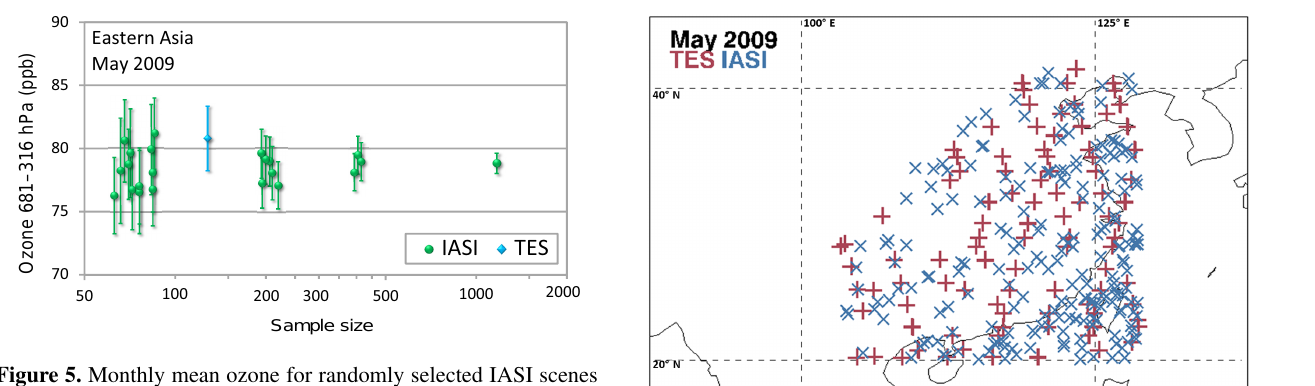
Figure 5. Monthly mean ozone for randomly selected IASI scenes within the eastern Asia ROI for May 2009. IASI-TOE data have been offset-corrected. A sample of 200 IASI scenes is deemed suf- ficient for an uncertainty of 1.9ppb or better for an area the size of the eastern Asia box.